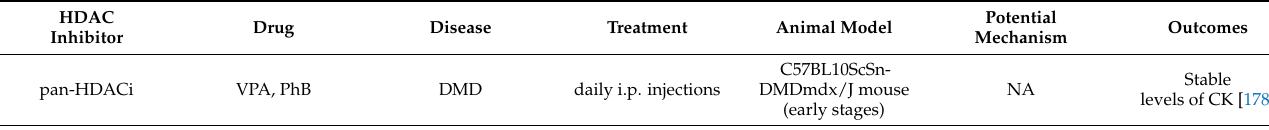
Potential Mechanism